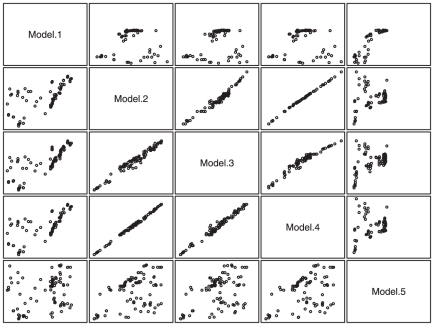
Plots of the mean rank (lower diagonal of sub-plots) and standard deviation in rank (upper diagonal of sub-plots) in the posterior distributions of the rankings from the five BLVMs.The two set of sub-plots are all plotted on the same scale.